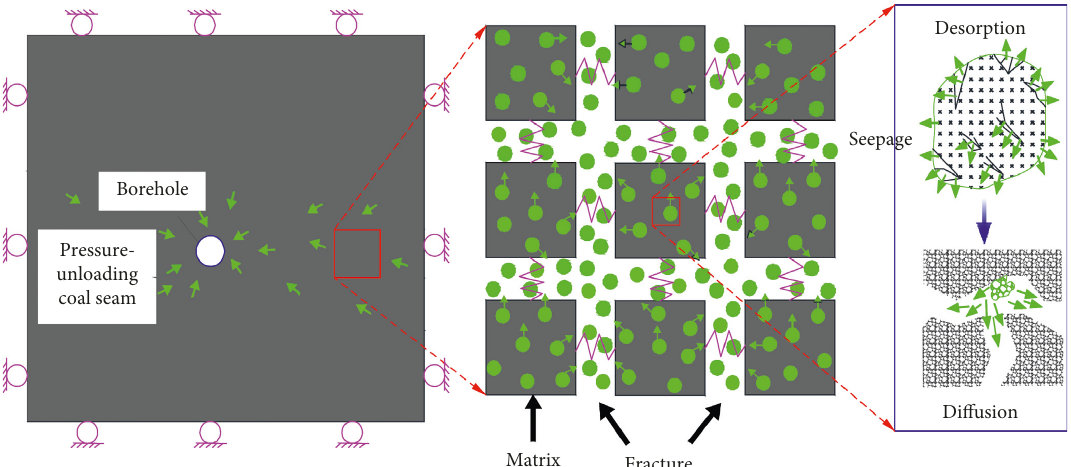
Figure 2: Gas migration during borehole